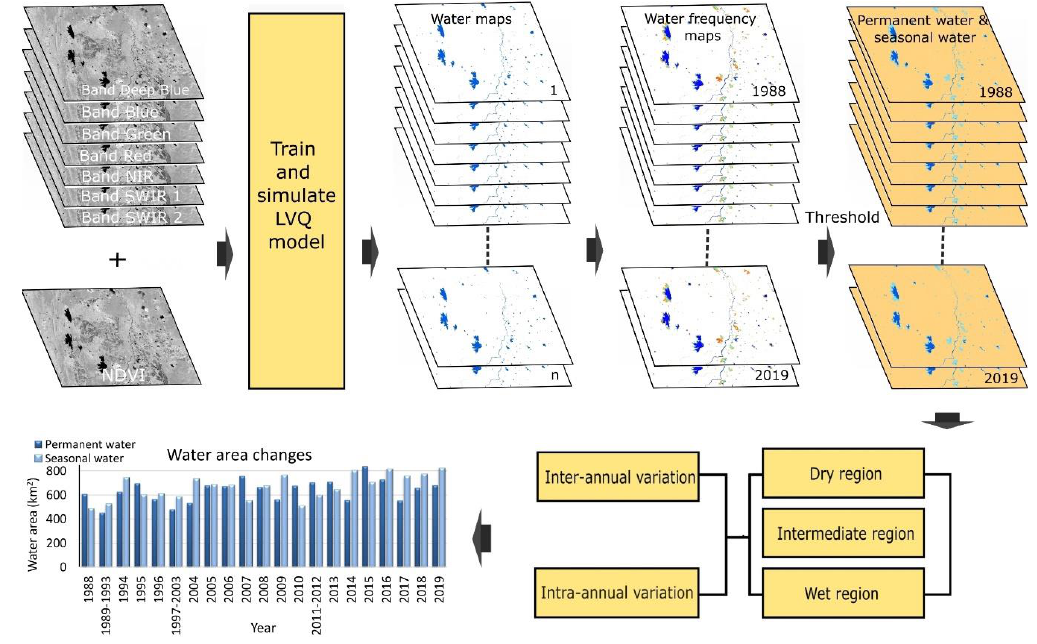
Figure 2. Flowchart of the applied methodology in this study.